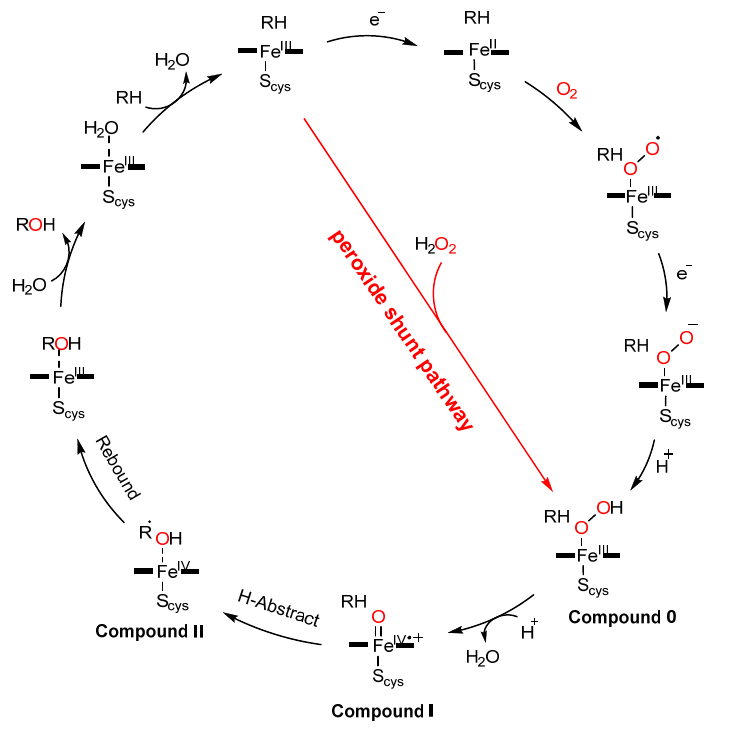
Figure 1. The catalytic cycle of cytochrome P450 monooxygenase and the peroxide-shunt pathway.